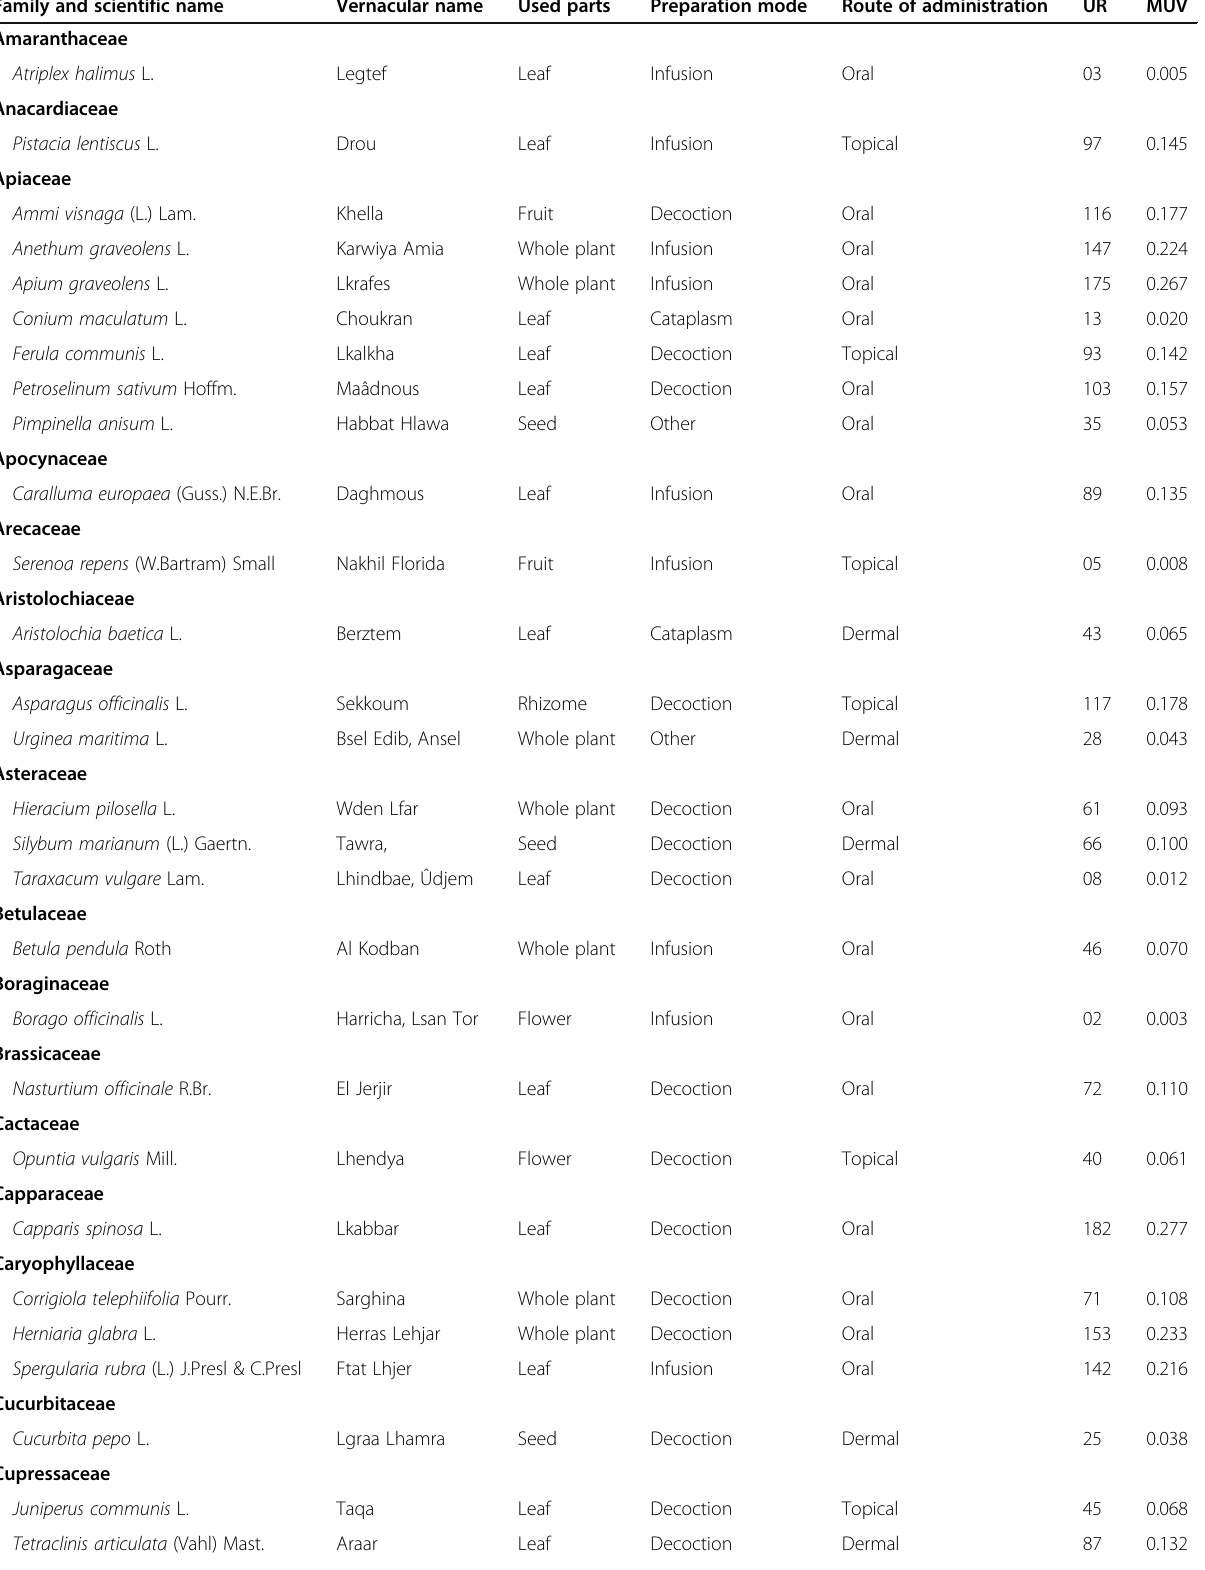
Table 2 Catalog of medicinal plants used to treat cystitis problems in the Rif,